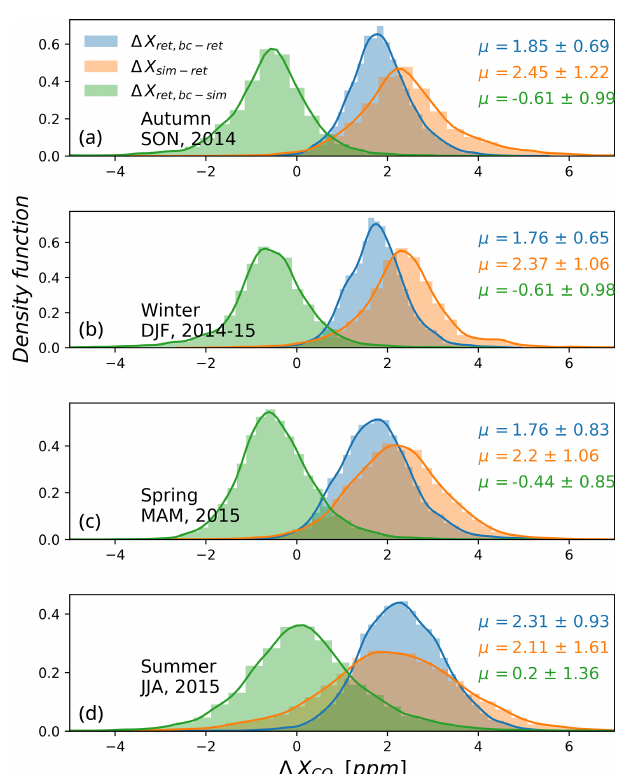
Figure 3. Kernel density distributions for residuals between simu- lated and satellite retrievals, grouped seasonally. Blue distributions show the impact of the OCO-2 bias correction on land nadir re- trievals. The orange and green curves show the difference between simulated retrievals and retrievals before and after bias correction, respectively. Printed numbers report the mean and standard devia- tion of residuals. Uncertainties in X sim are discussed in Sect. CO 2